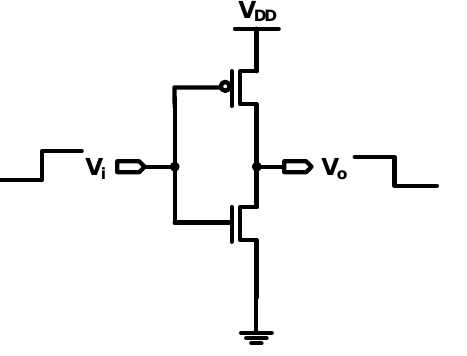
Figure 3. A CMOS logic inverter.